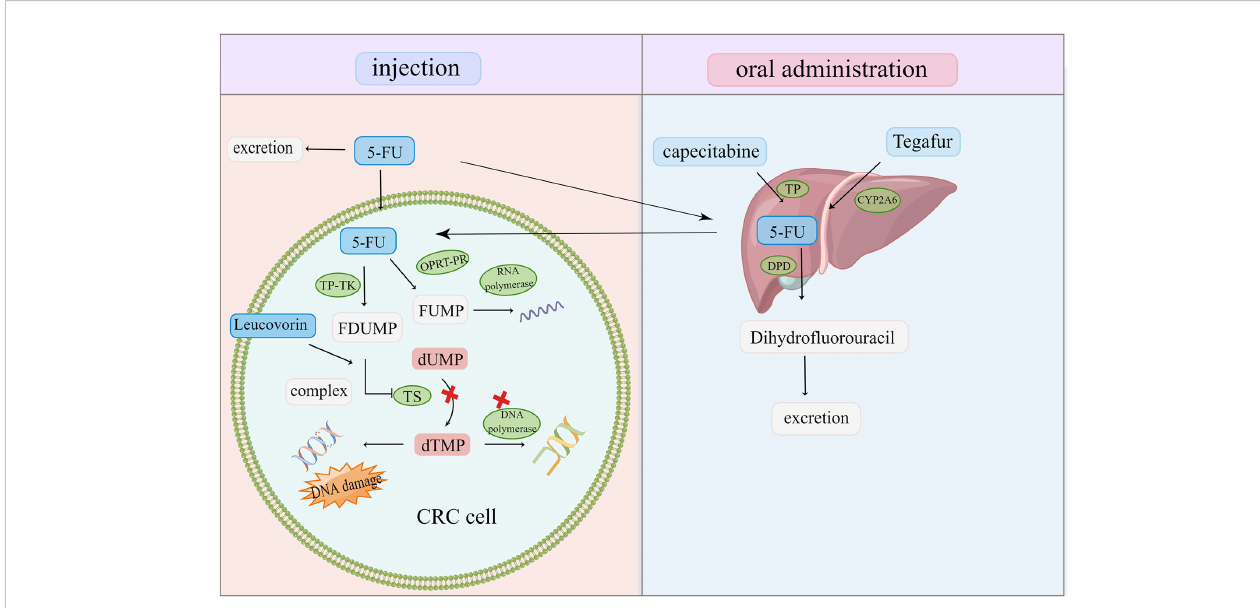
FIGURE 4 Oral and injected chemotherapeutic drugs are transformed into cytotoxic compounds after being activated and metabolized by various enzymes in the body. Once the target is changed and the drug is inactivated, CRC cells escape and become resistant to chemotherapy